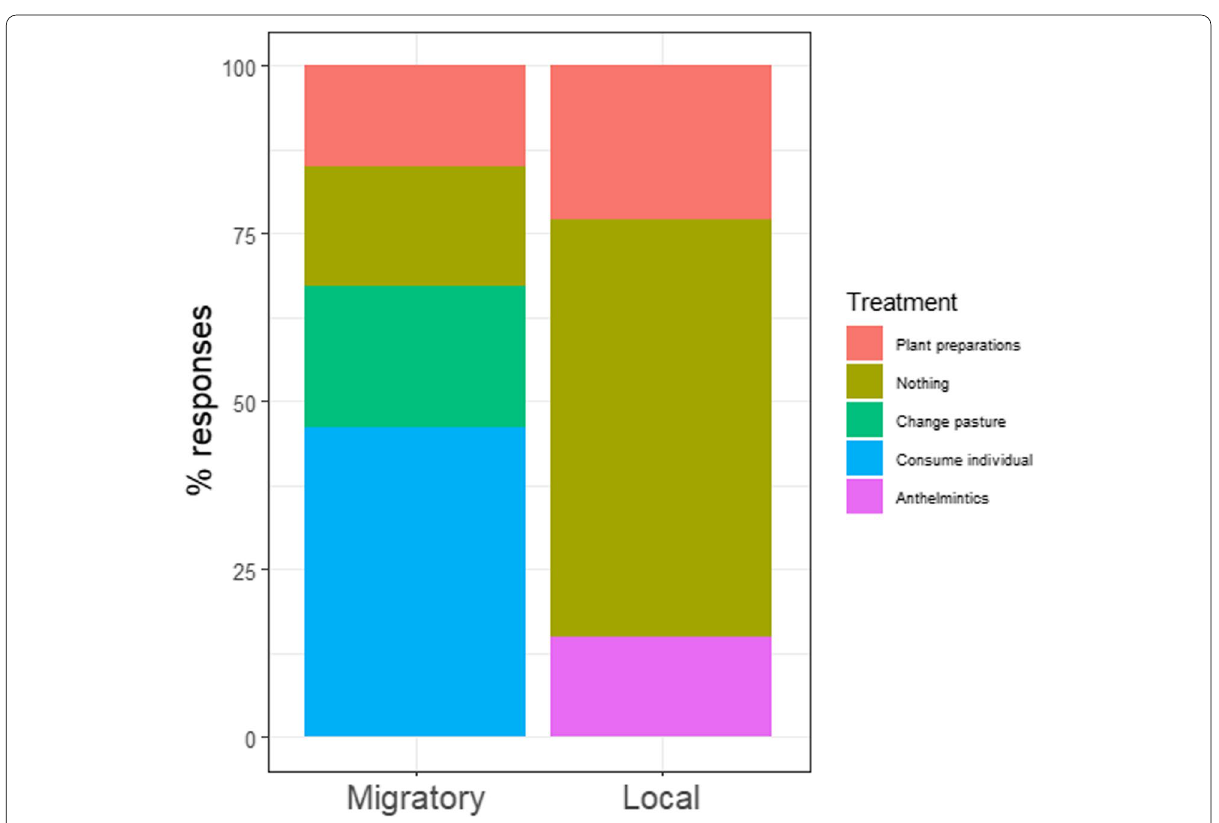
Fig. 6 Stacked bar graph displaying the bootstrapped mean % responses of different treatment types between migratory ( n 13)